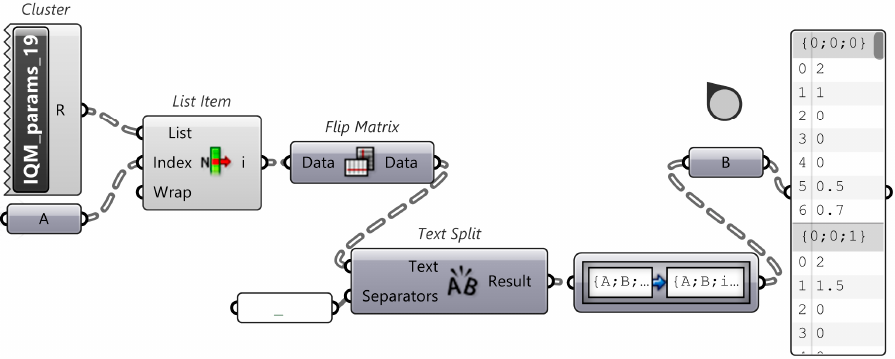
Figure 7. Part of the code introducing the requirements of the Italian legislation on structural anal-